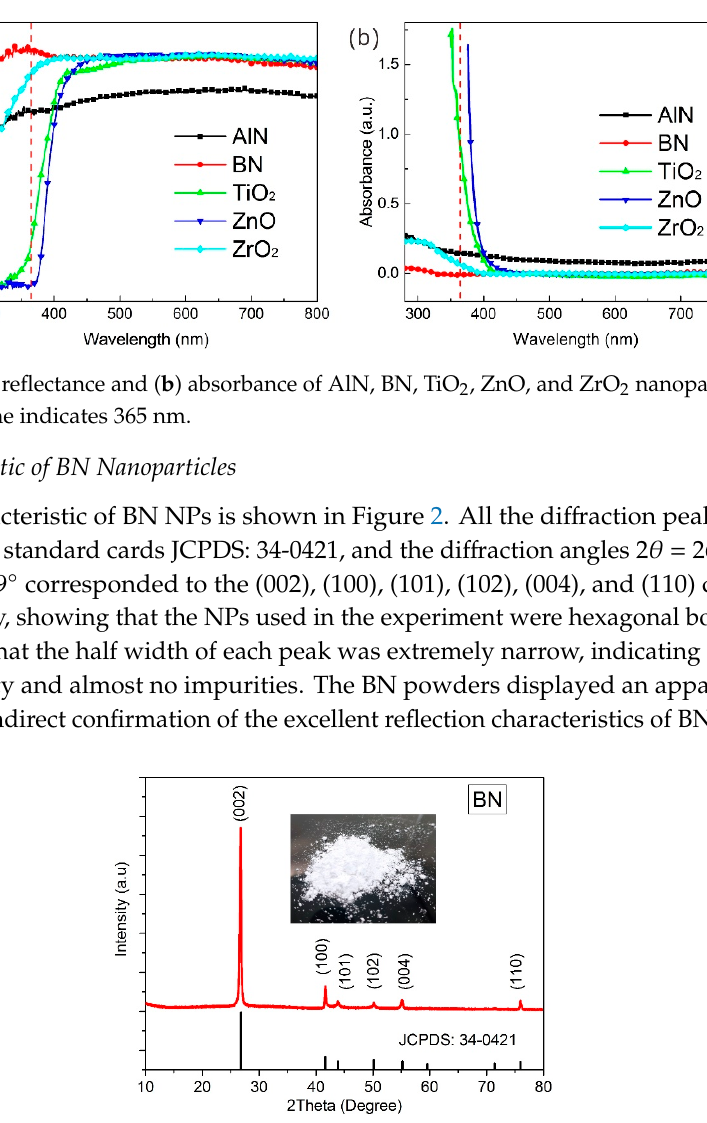
Figure 2. The XRD characteristic of the BN NPs.